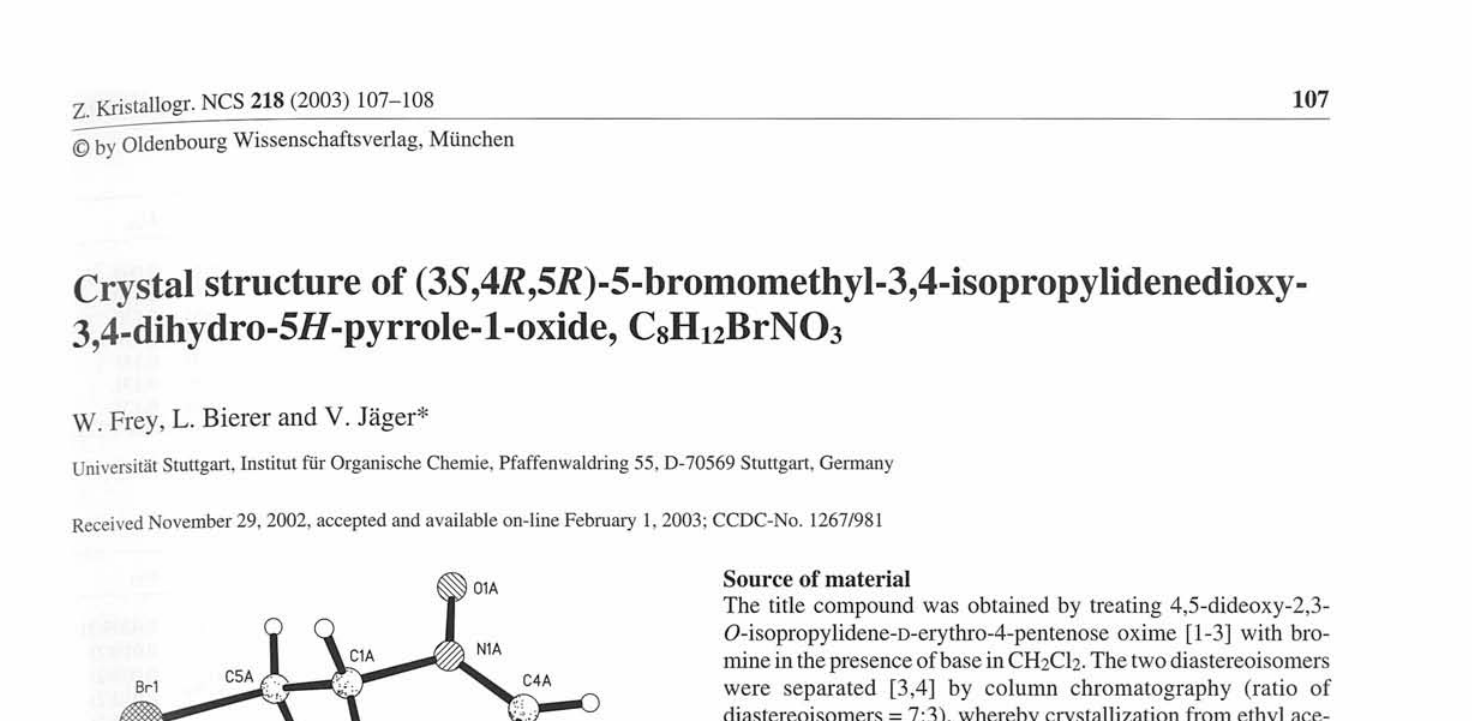
Table 1. Data collection and handling.